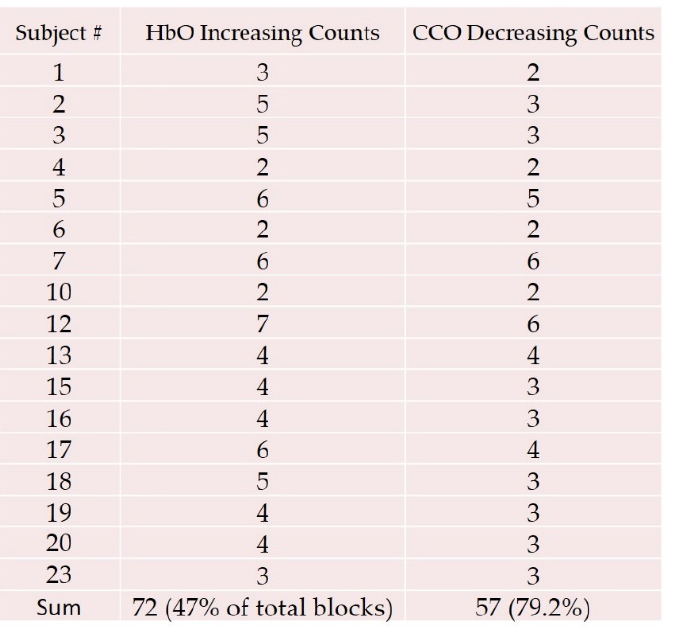
Figure 18. Table illustrating the “HbO increasing” screening of the 17 participants after removing the outliers. The second column represents the number of data blocks with HbO increasing (out of nine), while the third column shows the number of data blocks with CCO decreasing.